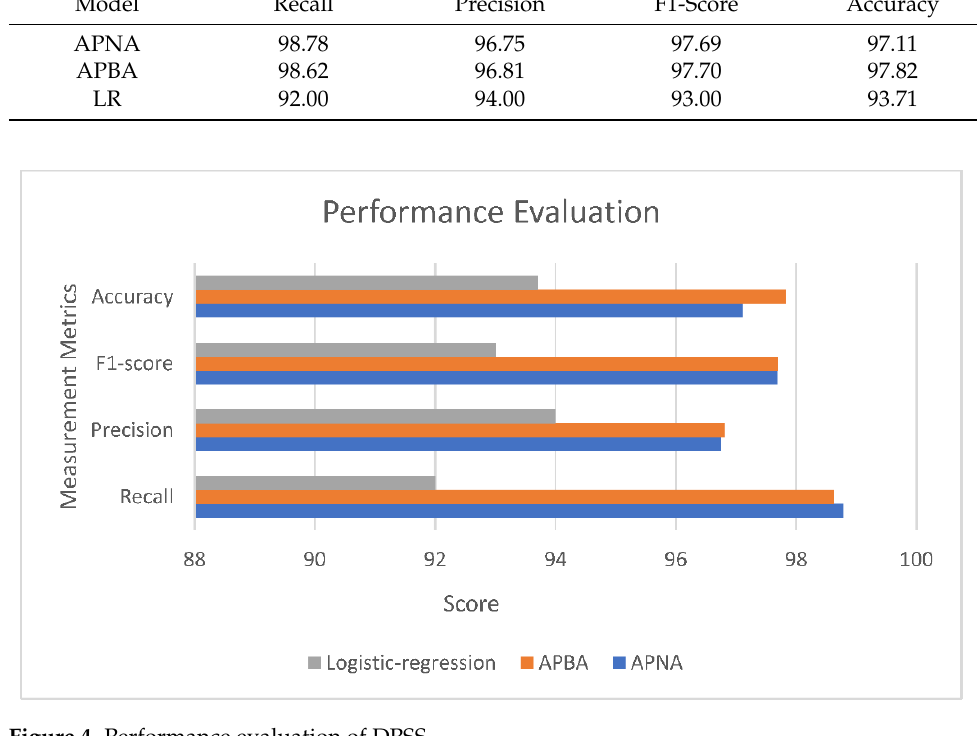
Figure 4. Performance evaluation of DPSS . Table 2. Performance evaluation of machine learning models